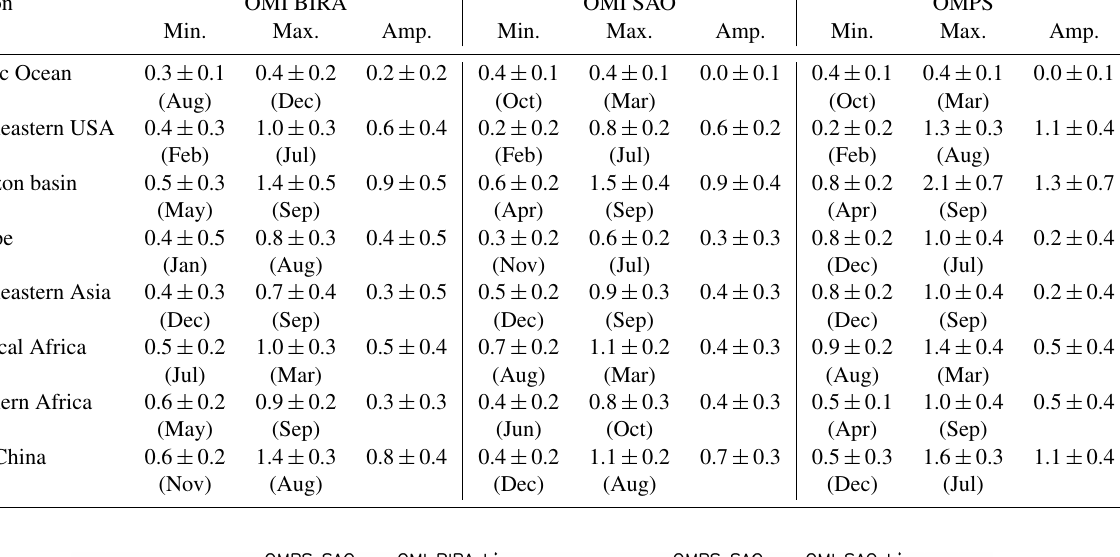
Table 5. Minimum (Min.), maximum (Max.), and amplitude (Amp.) of monthly mean time series for each region and retrieval. H 2 CO VCDs are expressed in 10 15 moleculescm − 2 . The error associated with each value is the standard deviation of the values considered in the calculation of the monthly mean. In parentheses, the month in which the minimum or the maximum was observed is indicated. Region OMI BIRA OMI SAO